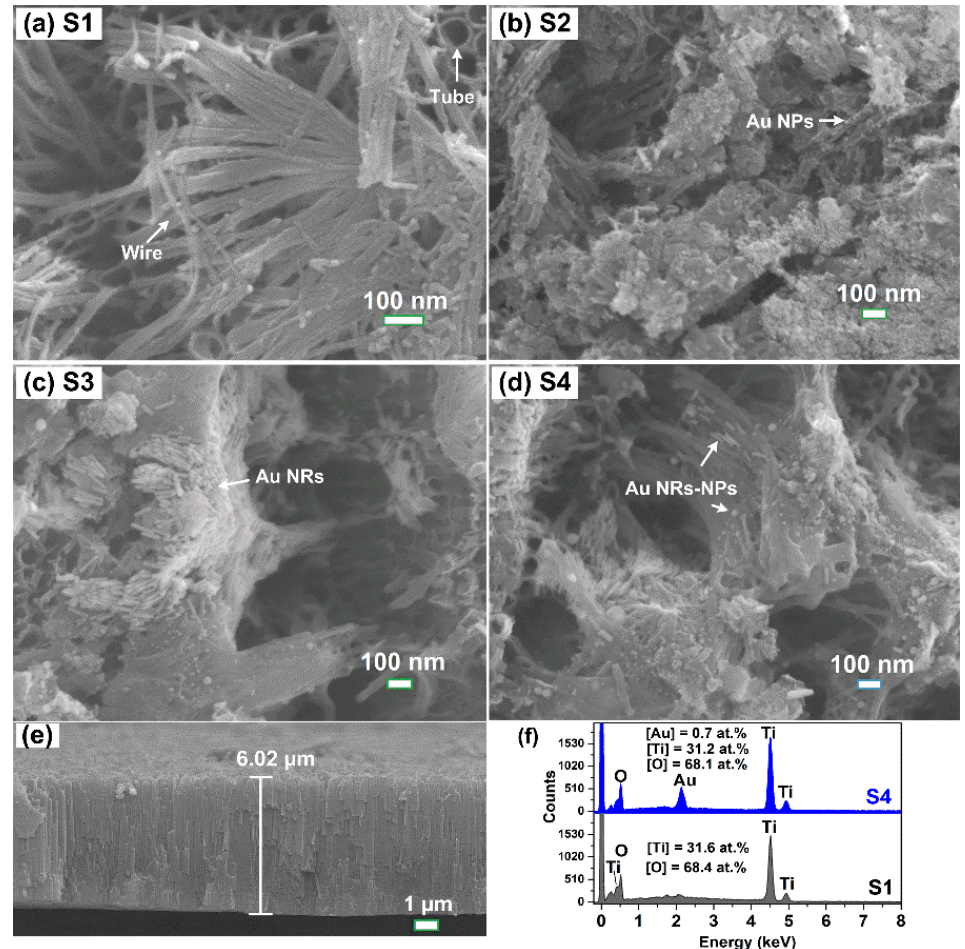
Figure 4. SEM images of ( a ) TNWs/TNAs (S 1 ), ( b ) Au NPs-TNWs/TNAs (S 2 ), ( c ) Au NRs- TNWs/TNAs (S 3 ), and ( d ) Au NPs-NRs-TNWs/TNAs (S 4 ). ( e ) A typical cross-sectional SEM image of the TiO 2 films in this study. ( f ) The typical EDS spectra of S 1 and S 4 in this study.